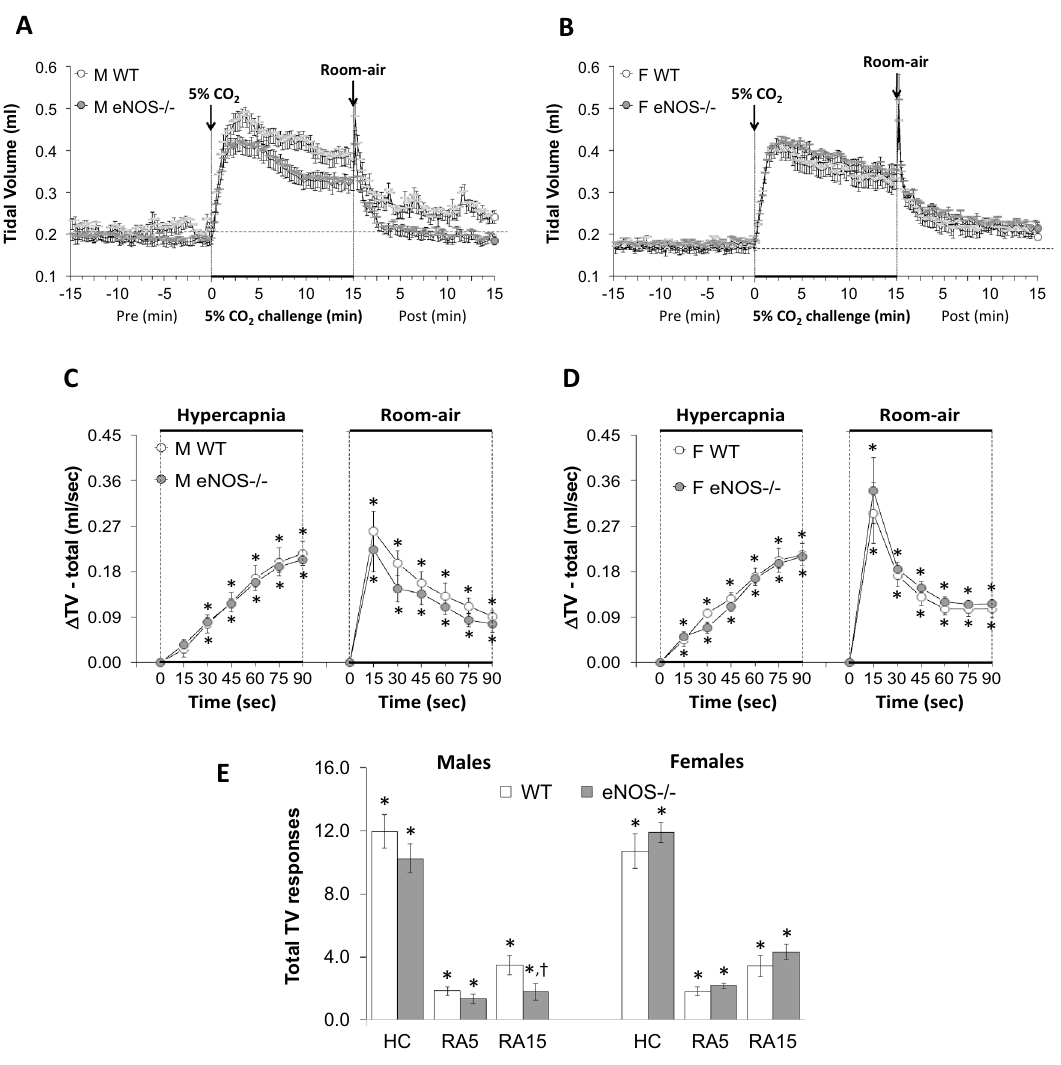
Figure 2. Panels ( A ) and ( B ): Tidal Volume (TV) values before, during a hypercapnic (HC) gas challenge (5% CO 2 , 21% O 2 , 74% N 2 ) and upon return to room-air in male (M) and female (F) wild-type (WT) and eNOS knock-out (eNOS-/-) mice. Panels ( C ) and ( D ) Arithmetic changes in TV in male and female WT and eNOS- /- mice during the first 90 s of exposure to the HC challenge and the first 90 s upon return to room-air. Panel ( E ) Total changes in TV in male and female WT and eNOS-/- mice during the HC challenge and during the first 5 min (RA5) and entire 15 min (RA15) return to room-air. The data are presented as mean ± SEM. * P < 0.05, significant change from pre-values. † P < 0.05, eNOS-/- versus WT within each